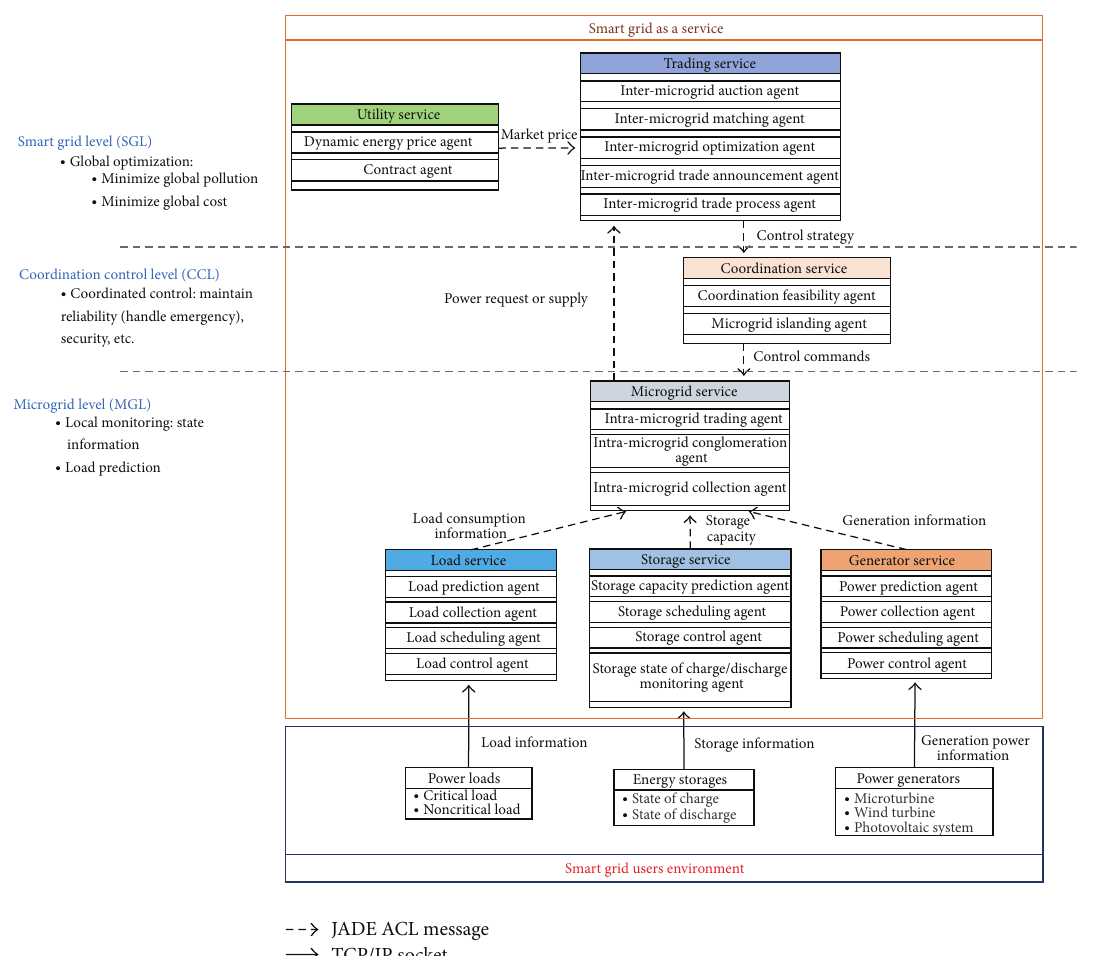
Figure 3: MAS-based smart grid service-oriented